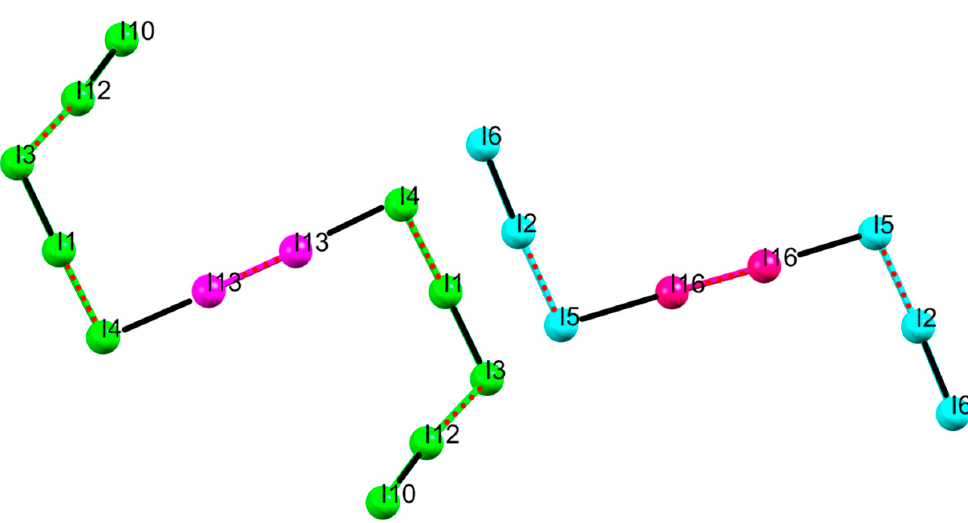
Figure 5. Detail of the long-short alternating I–I interatomic distances involving the two I 2 molecules found within the crystal structures. Inter- and intramolecular interatomic distances which are found shorter than reference values are displayed with solid black lines, those which are found longer are displayed with dotted red lines. Arbitrary color is used to mark symmetry equivalent polyiodides.